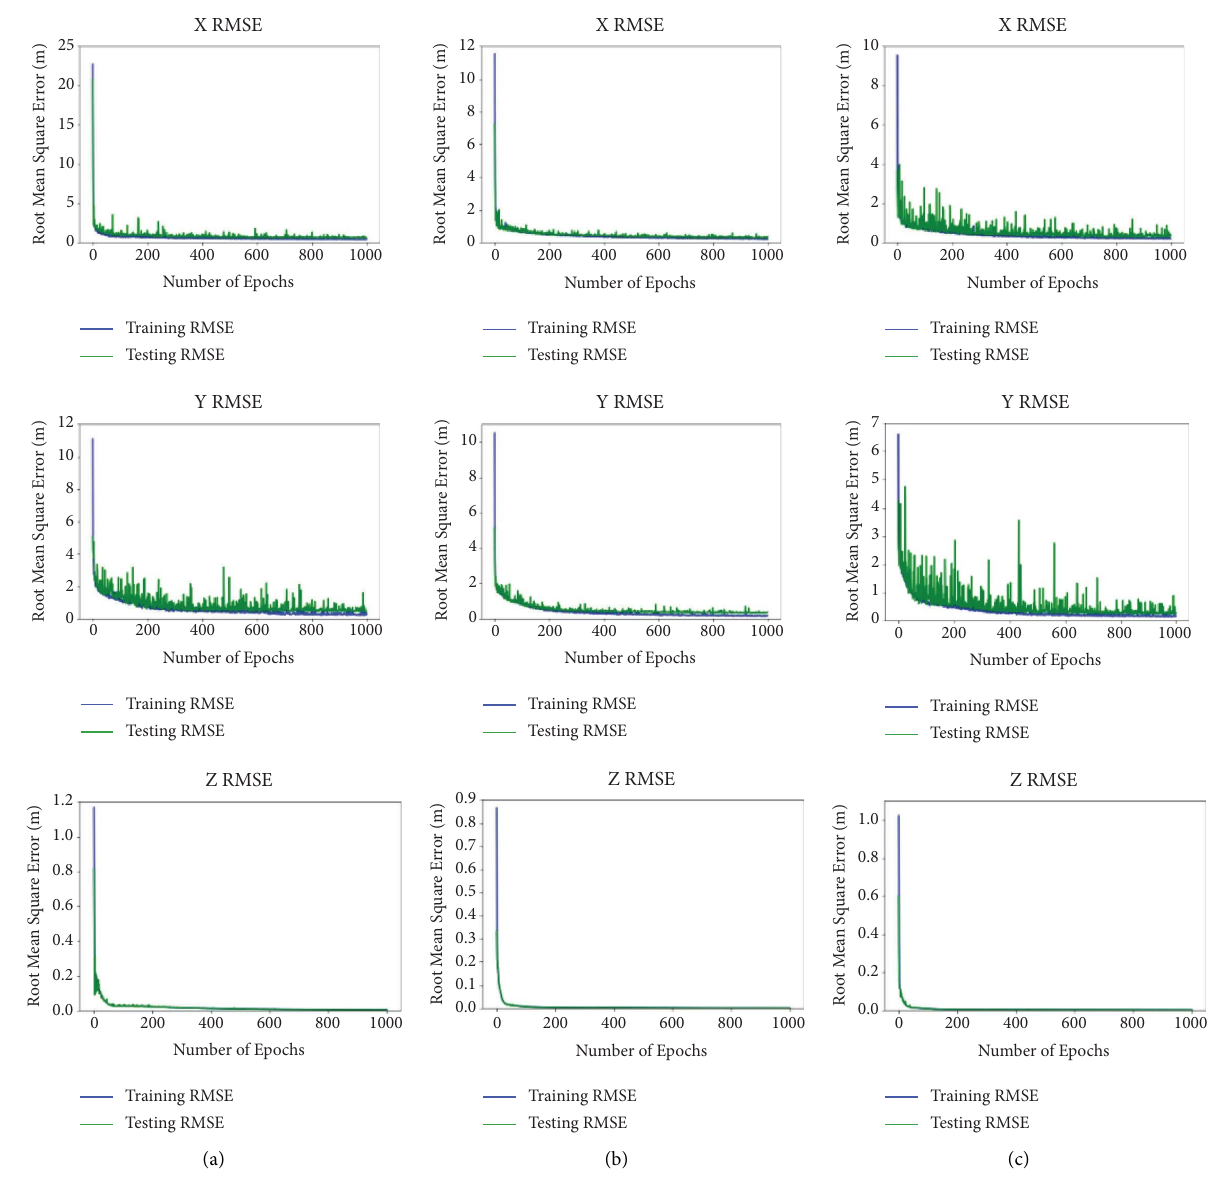
Figure 9: FCDNN RMSE (a) 1 AP pair, (b) 2–10 AP pairs, and (c) 1–10 AP pairs.